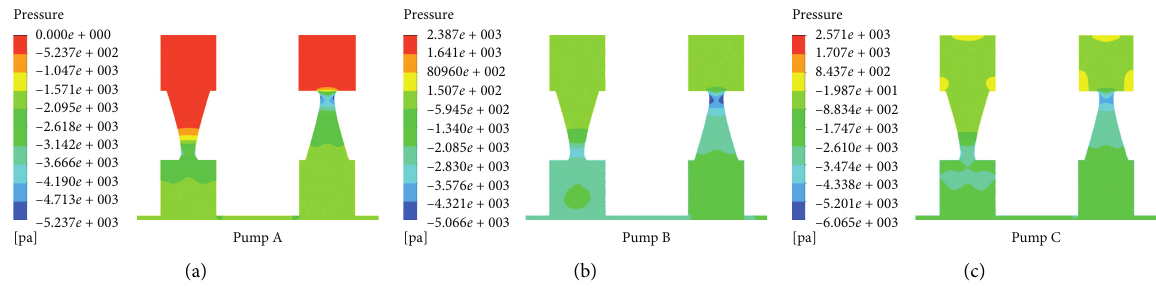
Figure 3: The pressure diagrams of the pumps in the suction stage.